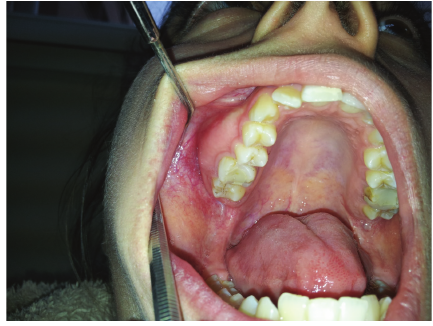
Figure 1: Expansive mass of the right maxilla.